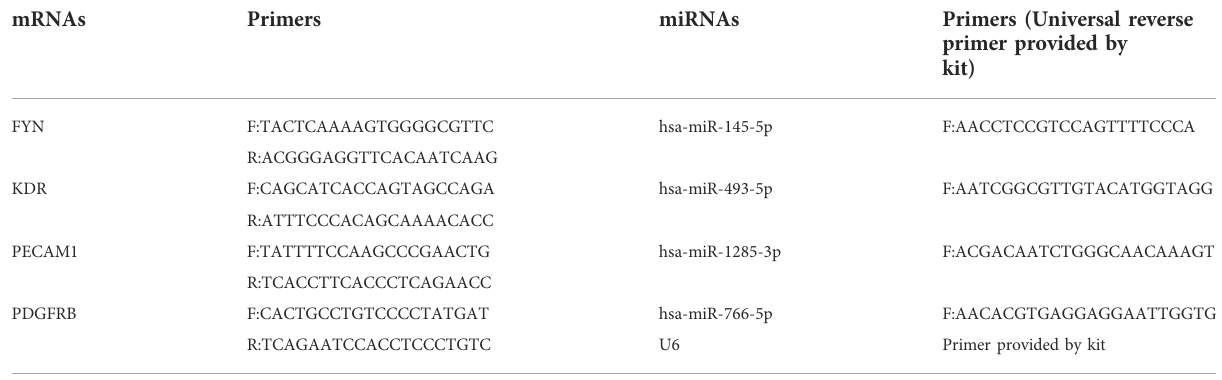
TABLE 2 Sequences of the primers used in qRT-PCR